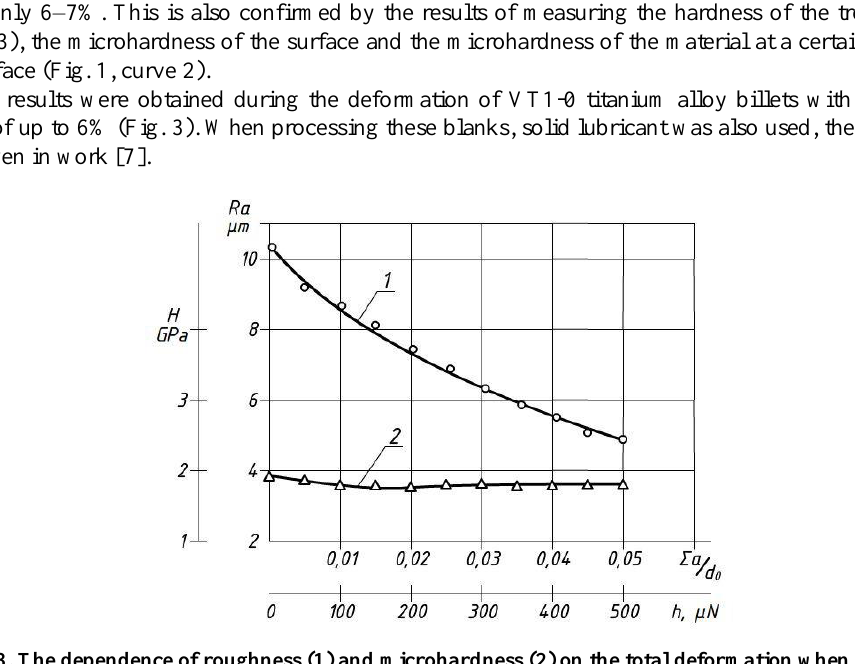
Fig. 3. The dependence of roughness (1) and microhardness (2) on the total deformation when processing bushings from titanium alloy VT1-0 with t 0 /d 0 =0,21 using solid lubricant based on diane epoxy resin ED-5 with colloidal graphite as a filler and modified organosilicon compounds